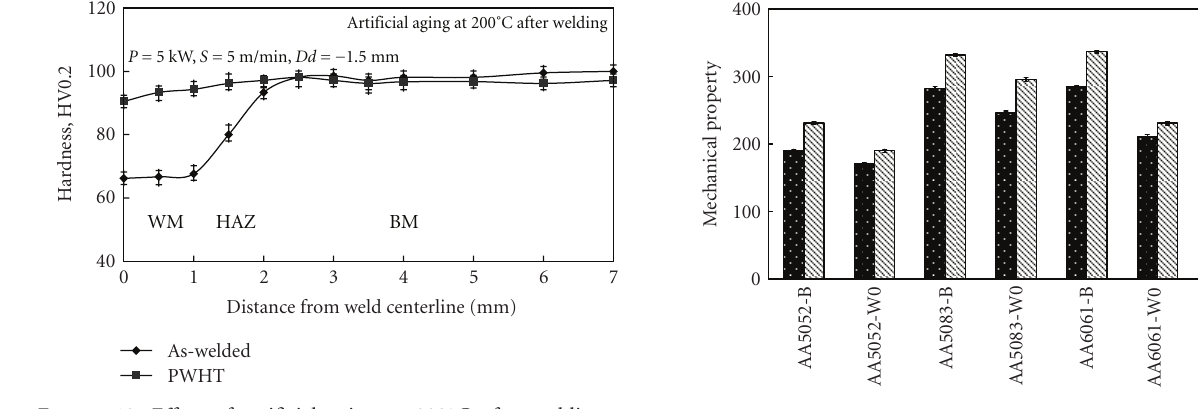
Figure 13: E ff ect of artificial aging at 200 ◦ C after welding on hardness of alloy AA6061 welded joint.